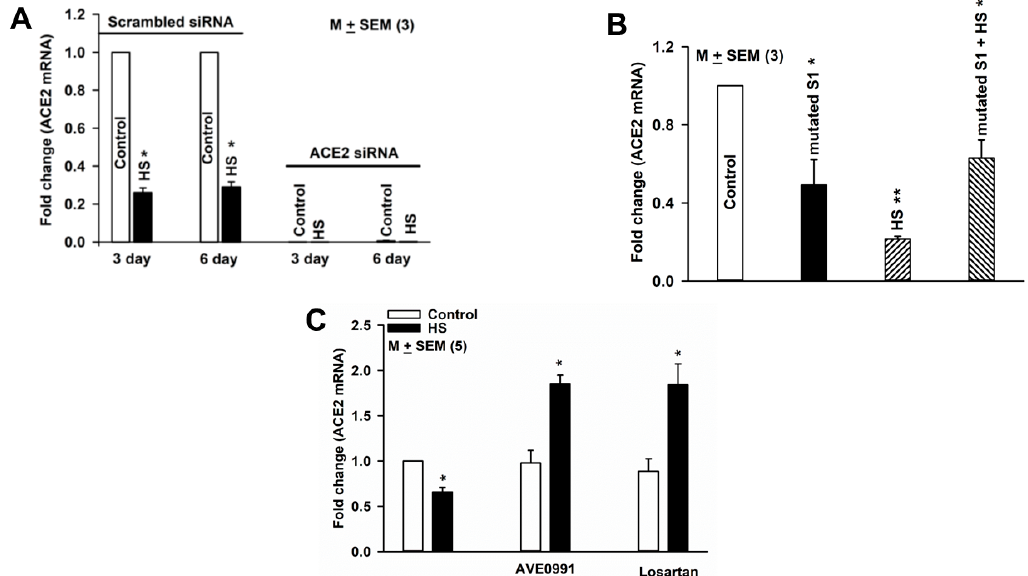
Nutrients 2022 , 14 , x FOR PEER REVIEW 12 of 20 Figure 6. Regulation of ACE2 mRNA expression in HBO cells: ( A ) effect of HS (20 mM NaCl) and ACE2 siRNA on ACE2 mRNA expression in HBO cells, * p = 0.0001; ( B ) effect of HS and mutated S1 protein on ACE2 mRNA expression in HBO cells; * p = 0.0172 (S1); ** p = 0.0001 (HS); and * p = 0.0114 (HS + S1); ( C ) effect of AVE0991 and losartan on ACE2 mRNA expression in HBO cells. HBO cells were cultured in control media and control media + HS in the absence and presence of AVE0991 (1 µM) or losartan (1 µM) for 3 days. Values are mean of qPCRs performed in two separate experiments. * p = 0.002 (HS); * p = 0.0008 (AVE0991); and * p = 0.007(losartan).